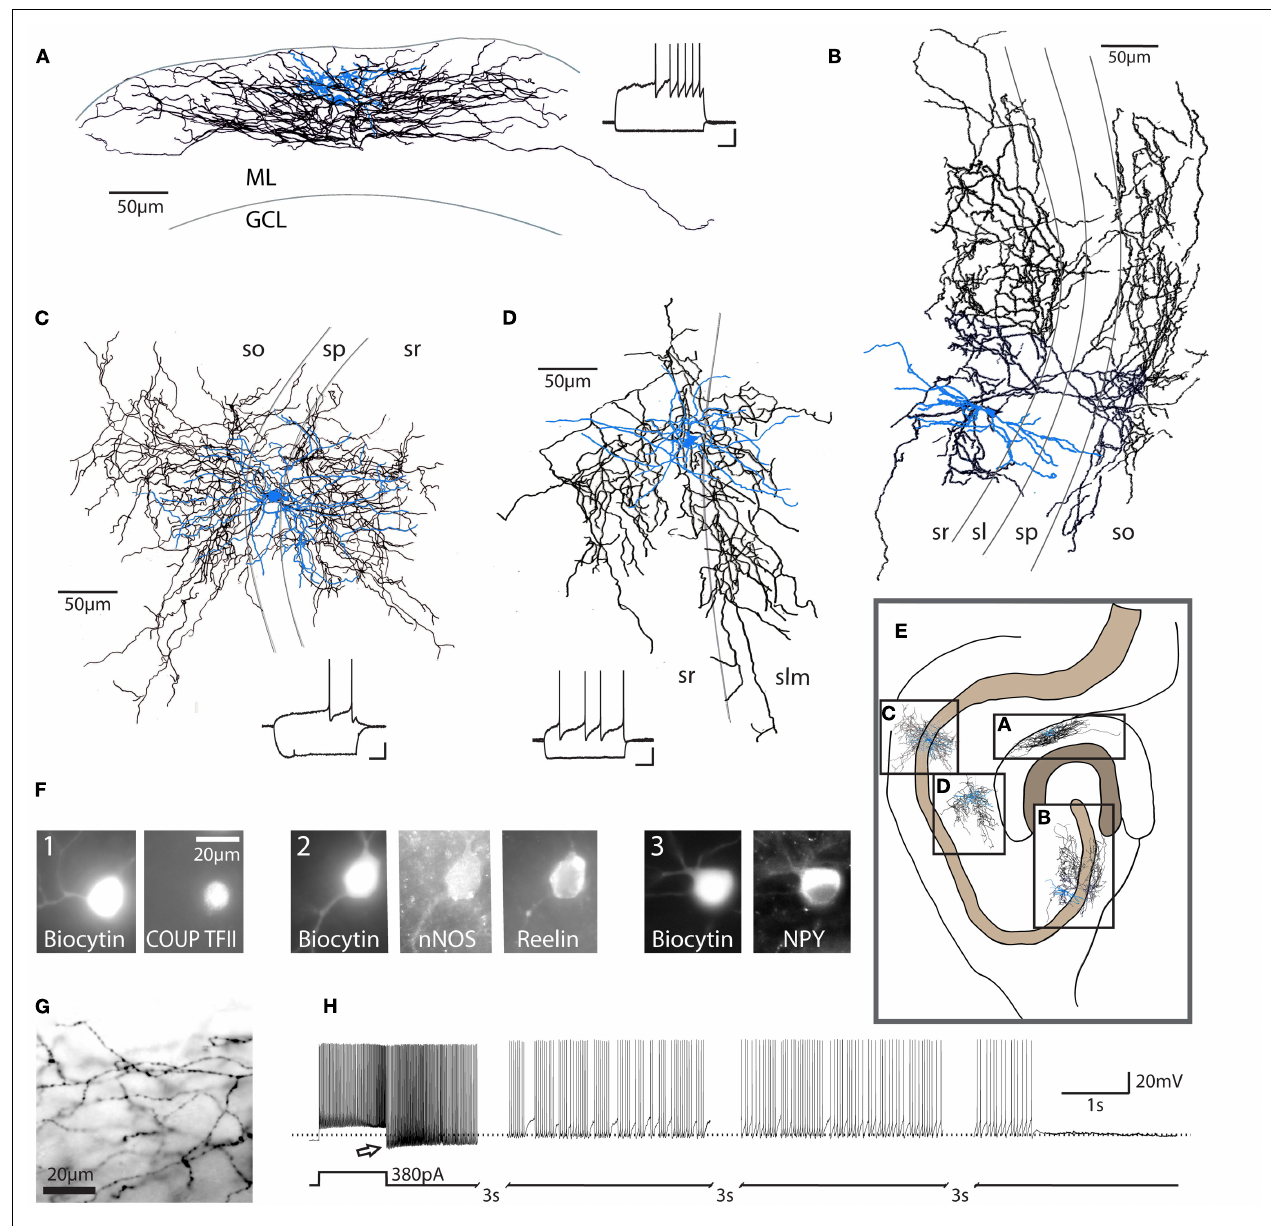
(see text). (G) Light microscopic image, showing the characteristic neurogliaform axonal arborization, with multiple axonal branches passing through a single plane of focus and frequent, small en passant boutons [same cell as (A) , scale bar 20 μ m]. (H) In addition to the classical late-spiking pattern characteristic of these cells, a high percentage of neurogliaform and Ivy cells display the recently described phenomenon referred to as persistent firing. After hundreds of action potentials induced by repeated depolarizing current steps (note that only the last depolarizing step is shown here), the cell continues to fire action potentials after the cessation of depolarizing input (bottom trace: schematic of current injection; top trace: current clamp recording, dashed line indicates − 60mV). Note the apparent low action potential threshold (arrow). Due to the long duration of the persistent firing state, the trace has segments omitted (indicated by hash marks) for illustration purposes. Reproduced and modified with permission from Armstrong et al. (2011) (A,F,G) , Szabadics et al. (2010) (B) , and Krook-Magnuson et al. (2011) (C,D,H)